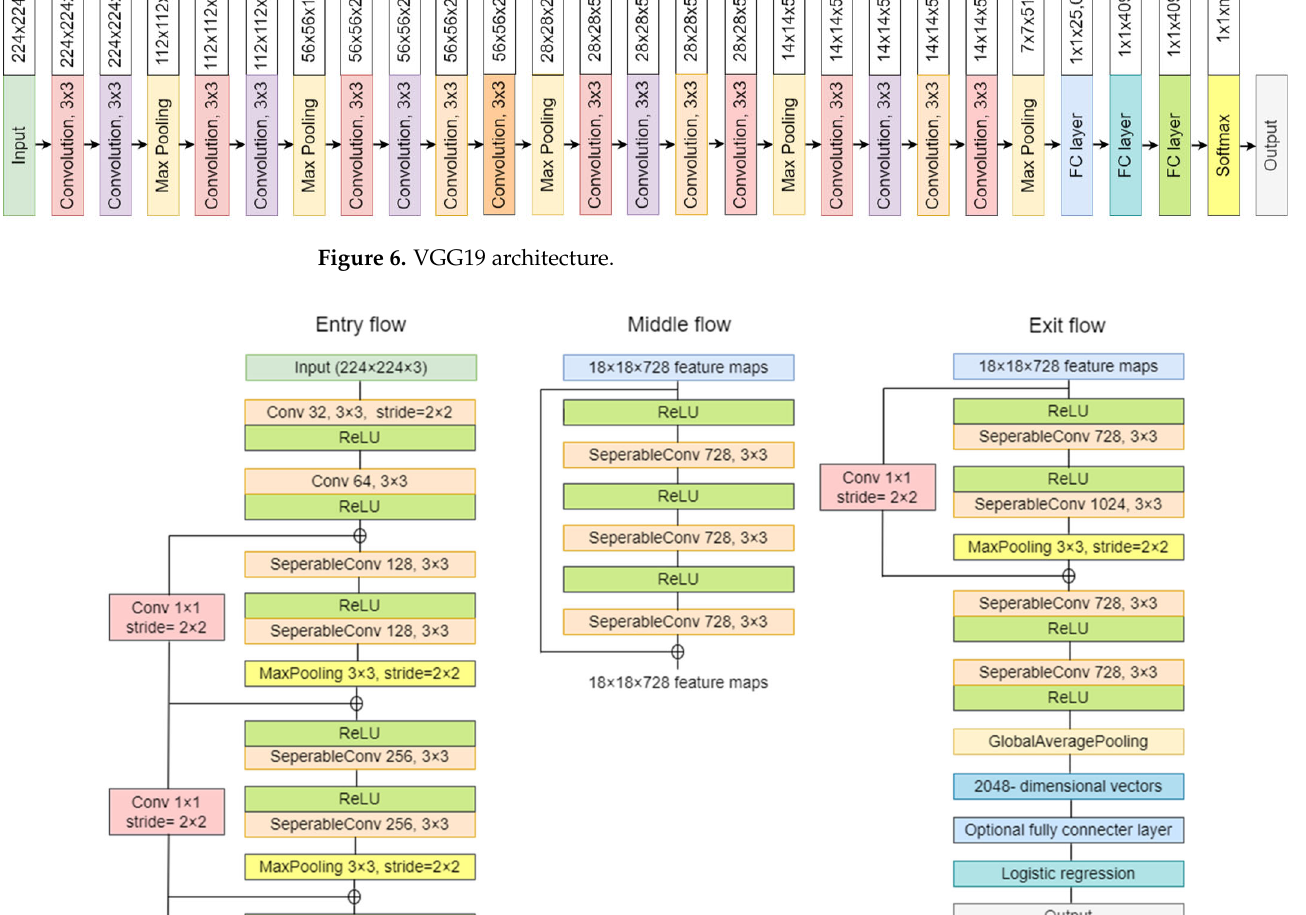
Figure 7. Xception architecture.